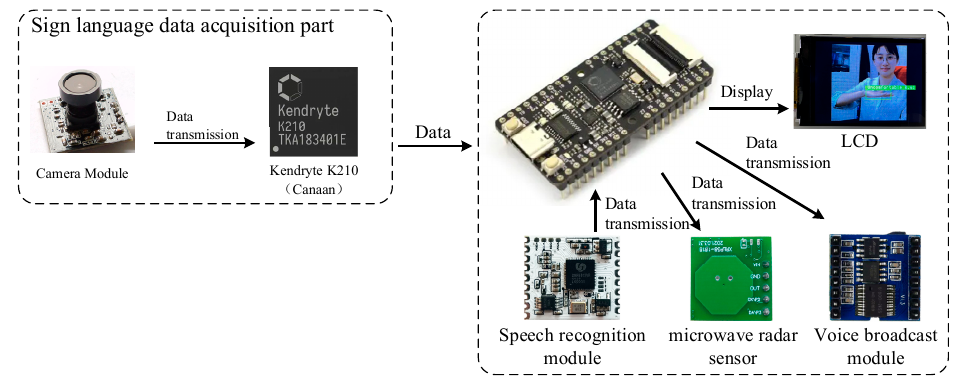
Figure 1. The architecture of the system.